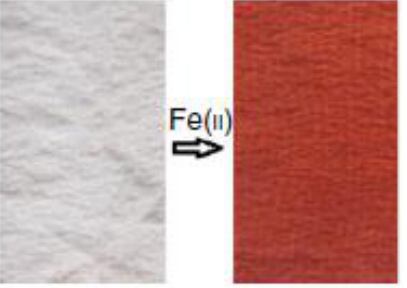
Figure 7. Fe(II)-sensitive color changes of silk fabric dyed with 1,10—phenanthroline (PHE) [81].